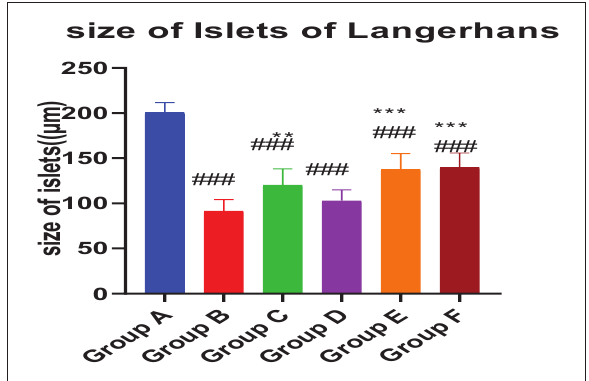
Fig -1: Comparison of mean size of islets of Langerhans of groups A, B, C, D, E and F ### indicates p-value is <0.001 as compared to group A. *** shows p-value is <0.001